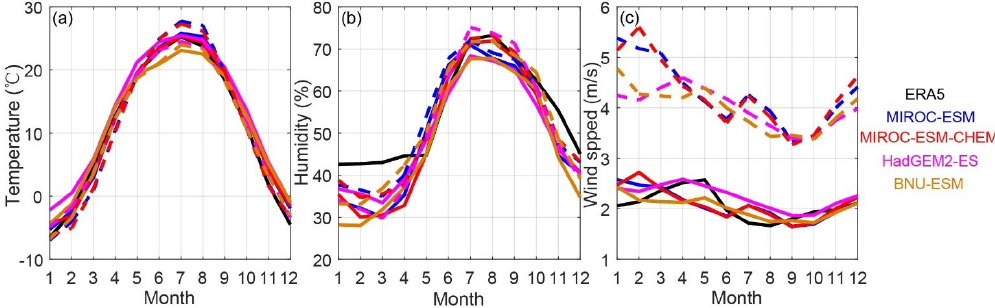
Figure 7. Seasonal cycle of multi-year averaged monthly temperature (a ), relative humidity (b) and wind speed (c) during 2008–2017 for Beijing. The solid lines are the WRF-QDM-ESM results, and the dashed lines are the WRF-ESM